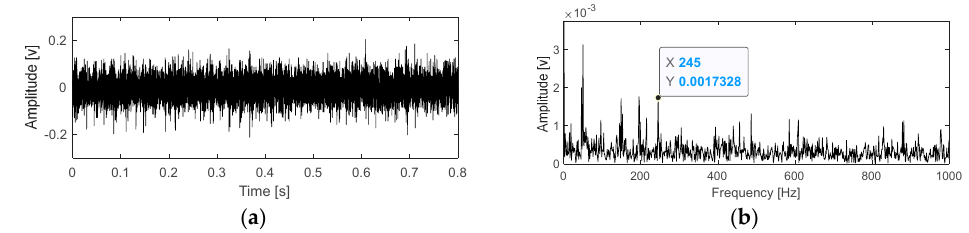
Figure 8. Time-domain waveform of the filtered experimental signal using cyclic Wiener filter with its envelope spectrum. ( a ) Time domain waveform of the filtered signal as shown in Figure 7c using cyclic Wiener filter. ( b ) Envelope spectrum of the signal as shown in ( a ).